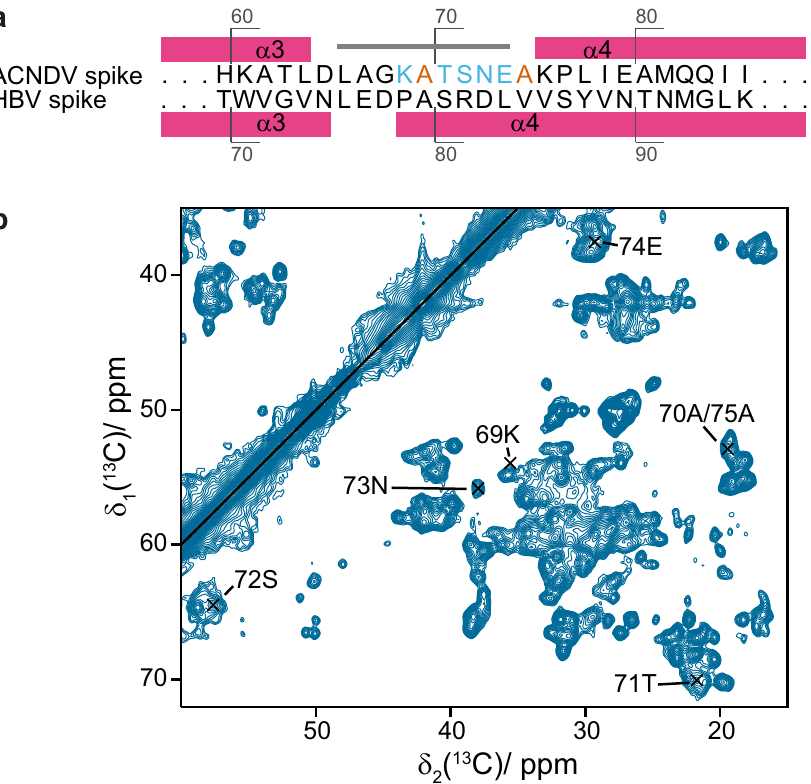
Fig. 4 | Spike residues wereonlyobserved by NMR notby cryo-EM.a Alignment of the sequences at the spike tips for ACNDV Cp (top row) and HBV Cp (bottom row). The alignment was adapted from 1 . Residues in the ACNDV sequence in light bluearetheonestentativelyassignedbyNMR(seepanel b ).Thepeaklabeled70A/ 75A in panel b could belong to either alanine residue (orange in panel a ). Other ACNDVresiduesinblackareunambiguouslyassigned(TableS5). n =1independent